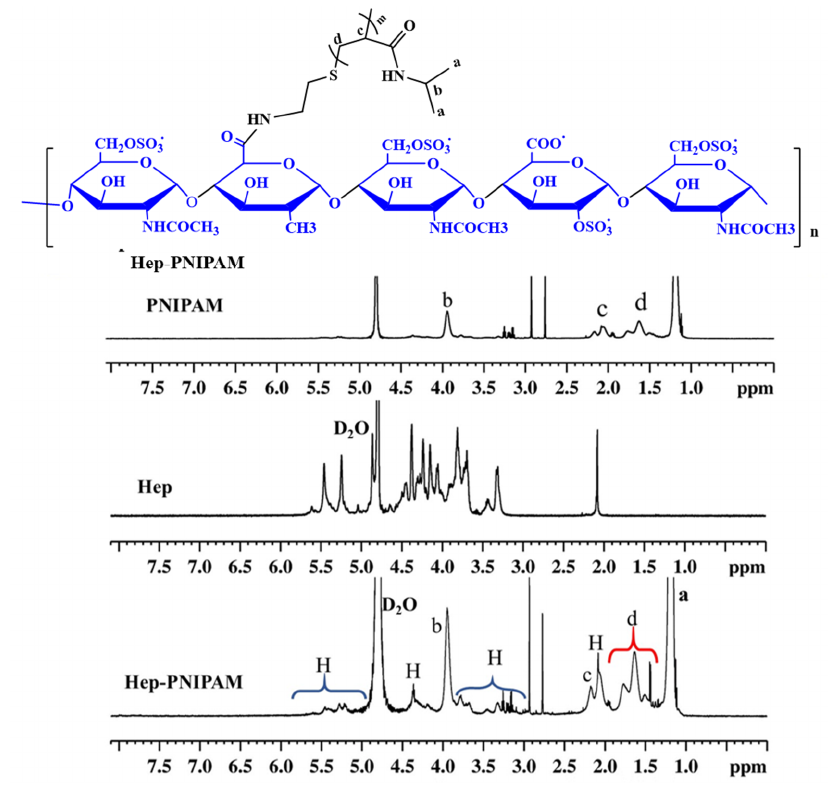
Figure 2. 1 H NMR of heparin (Hep) and copolymer (Hep-PNIPAM).